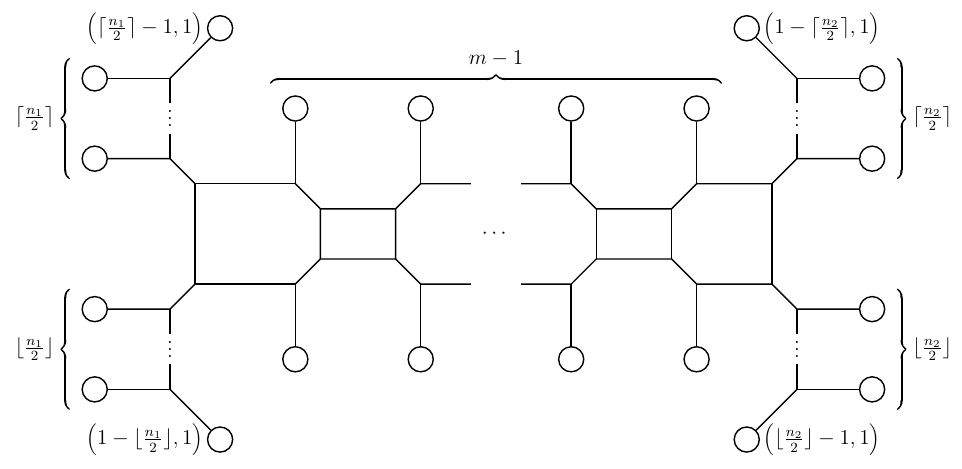
Figure 4 . Brane web for [ n 1 ] − SU(2) m − [ n 2 ] quiver gauge